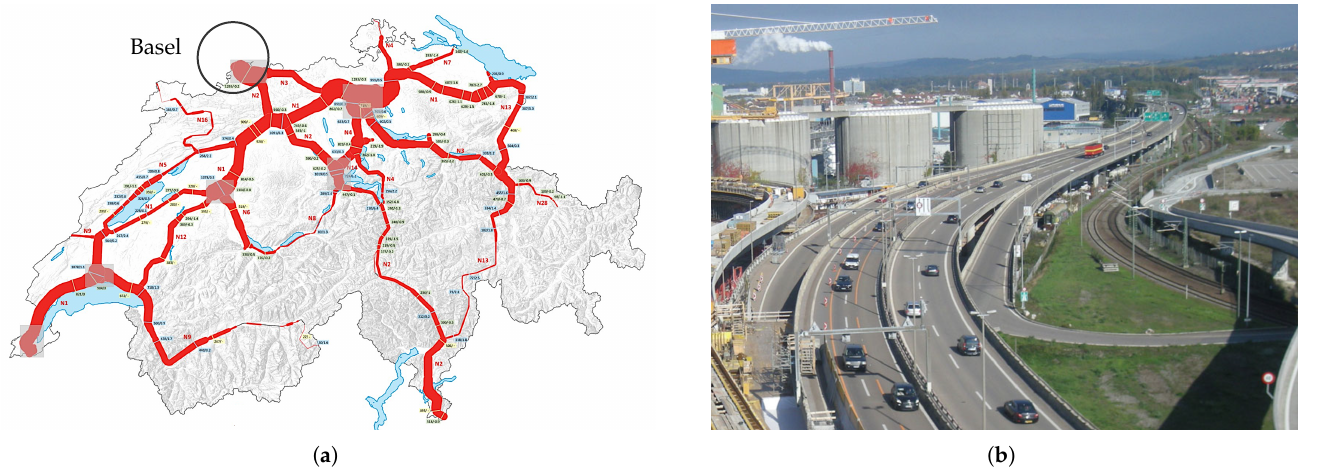
Figure 1. ( a ) The Swiss motorway network traffic in 2019, Basel location marked (https://www. astra.admin.ch/astra/de/home/themen/nationalstrassen/verkehrsfluss-stauaufkommen/